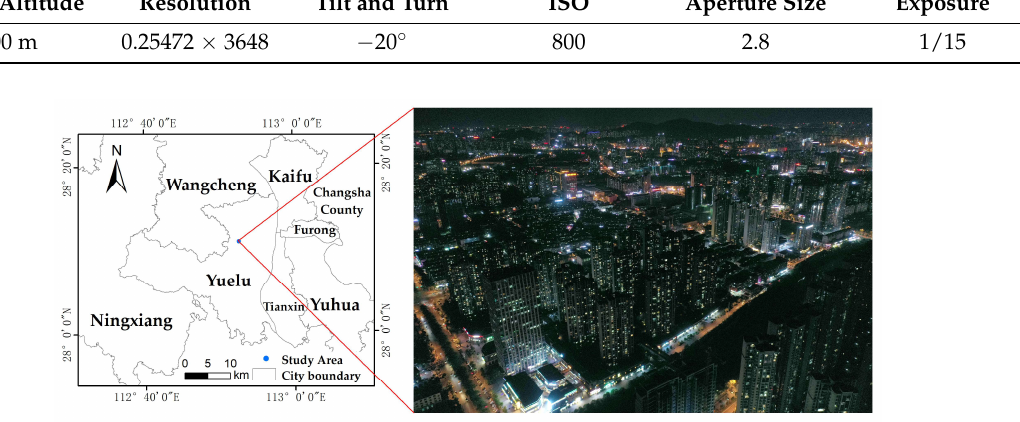
Figure 1. The study area.